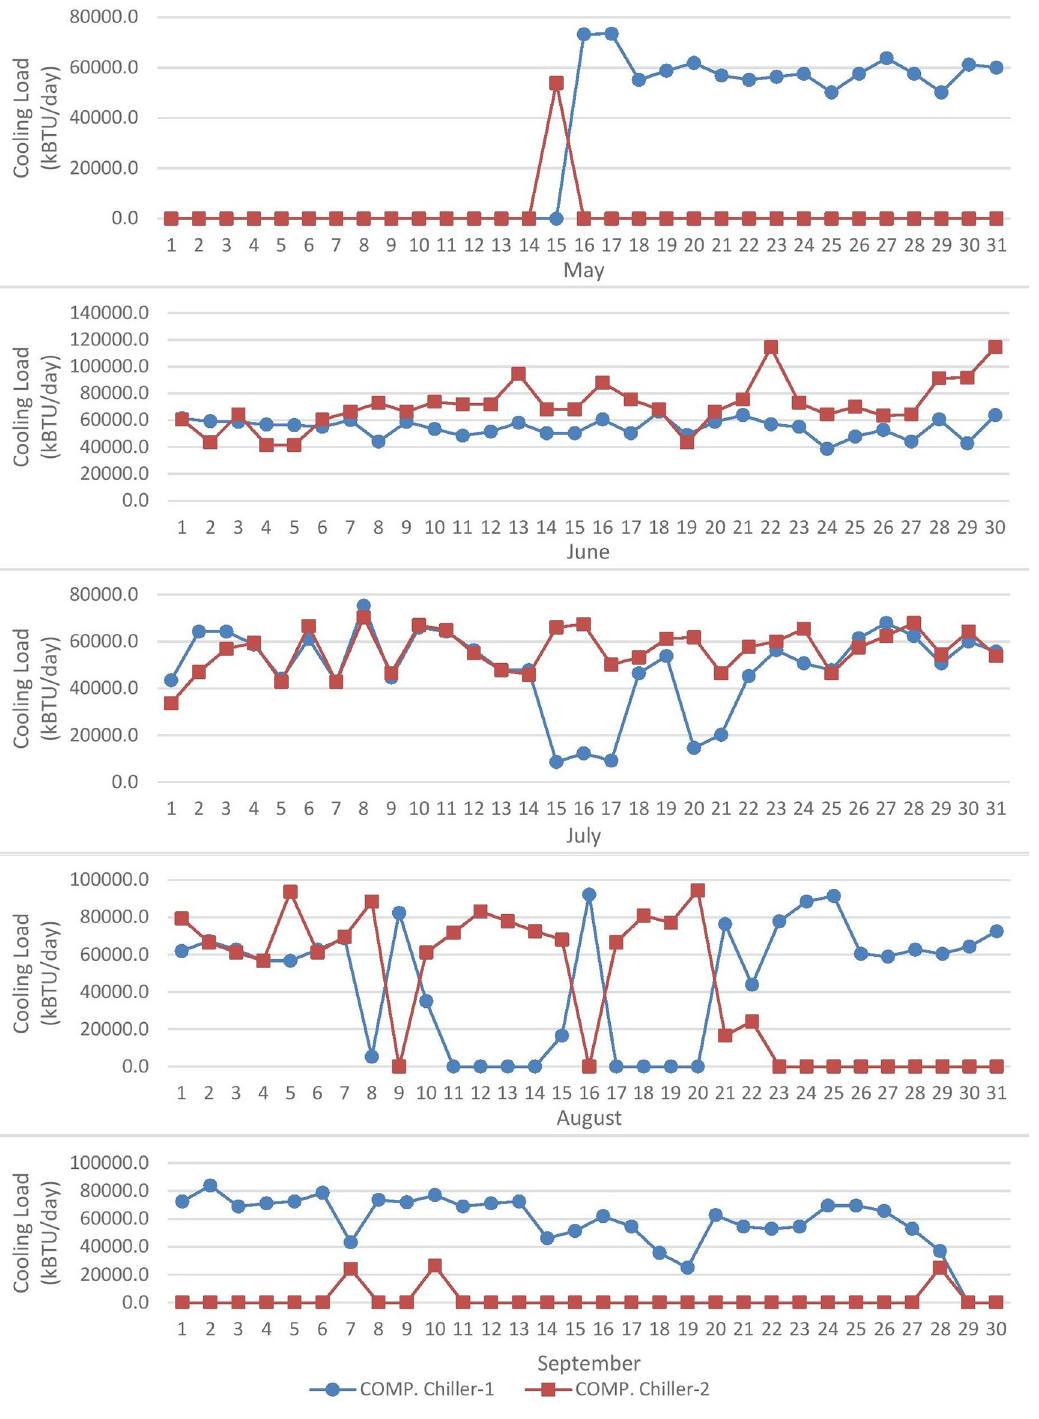
Fig. 3. Vapor compression chillers cooling load in May –